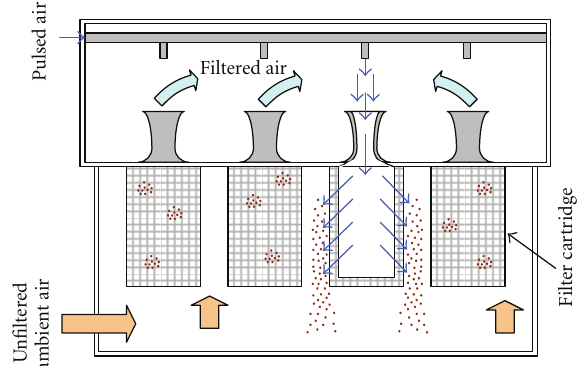
Figure 9: Example of operation of an updraft self-cleaning filters